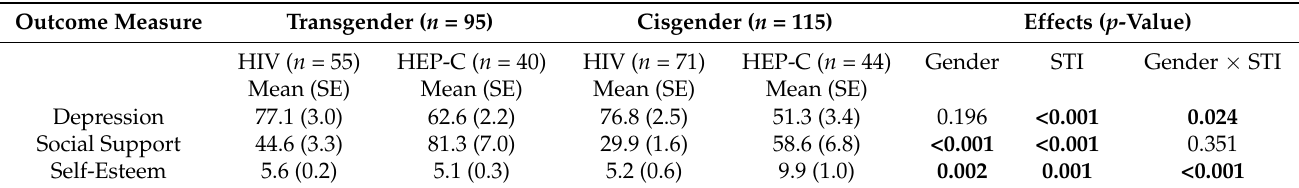
Table 2. Major outcome variables across transgender and cisgender participants with either HIV or HEP-C. Outcome Measure Transgender ( n = 95) Cisgender ( n = 115) Effects ( p -Value)